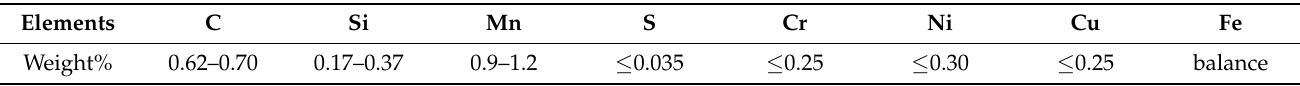
Table 3. Chemical composition of 65 Mn